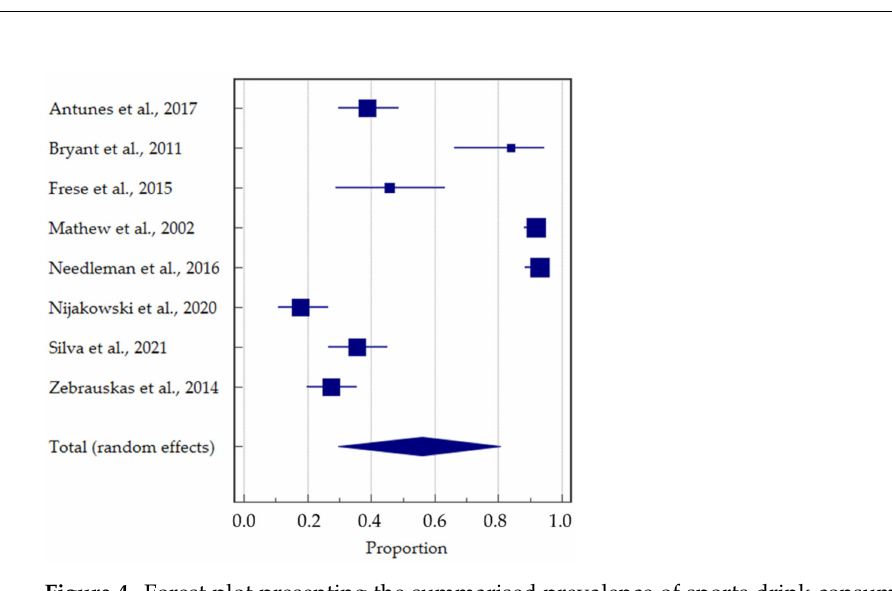
Figure 4. Forest plot presenting the summarised prevalence of sports drink consumption among physically active individuals.